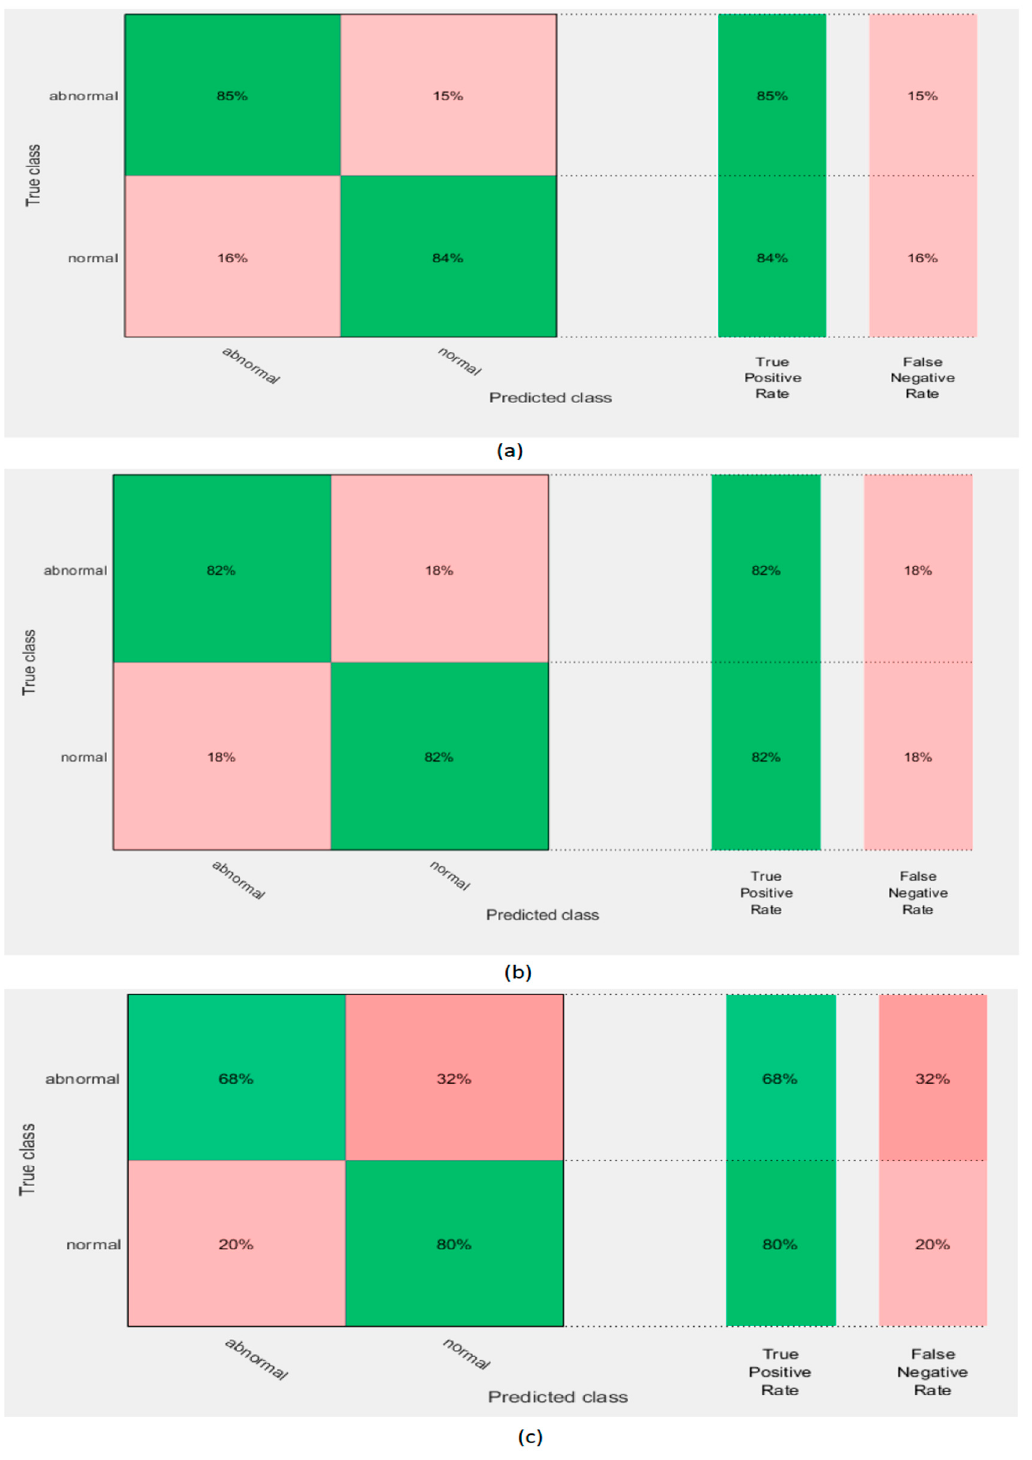
Figure 6. Confusion matrix of support vector machine (SVM) classifier trained with deep features extracted from the ( a ) GoogleNet DCNN,( b ) AlexNet DCNN, and ( c ) ResNet 50 DCNN after principal component analysis (PCA).